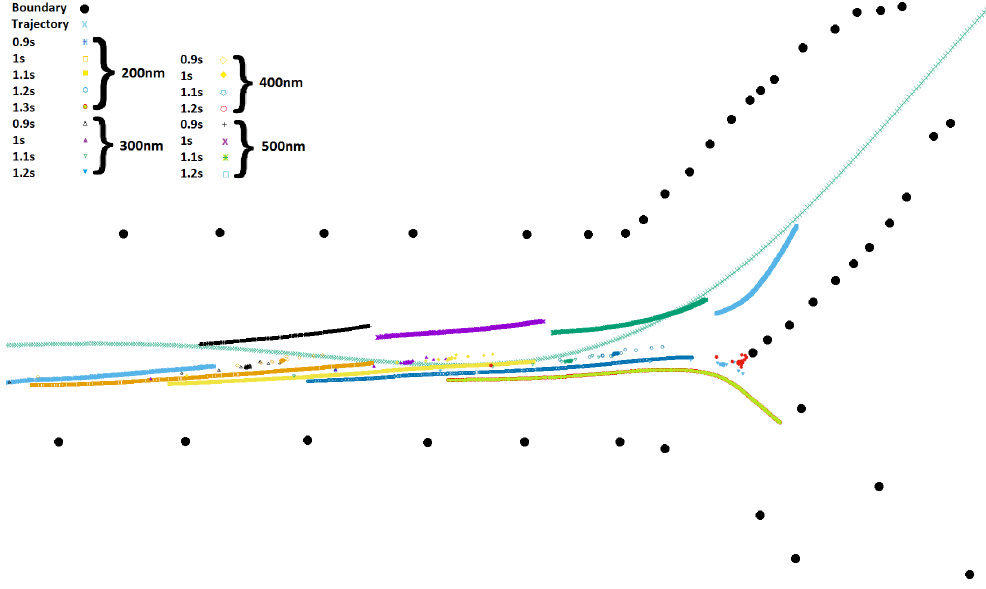
Figure 7. Projection of the positions of different diameter particles under different time steps of the navigation